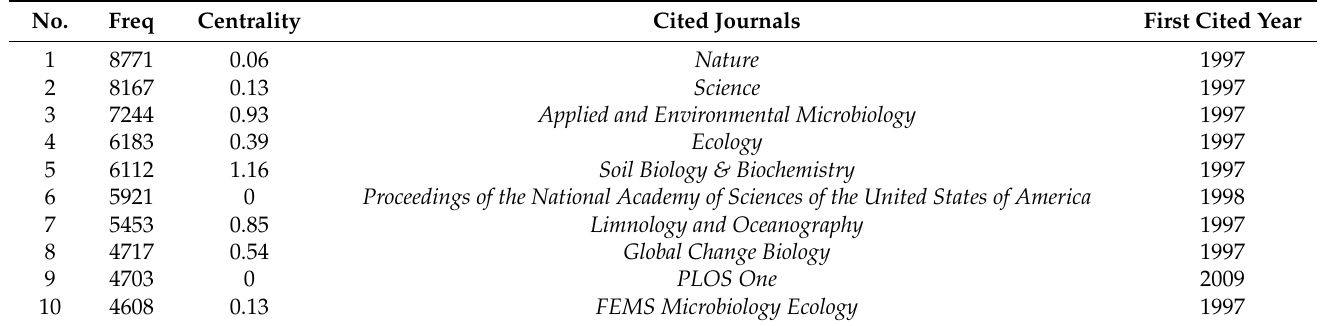
Table 3. Major research journals in the field of LCC and ZCC from 1997–2022.